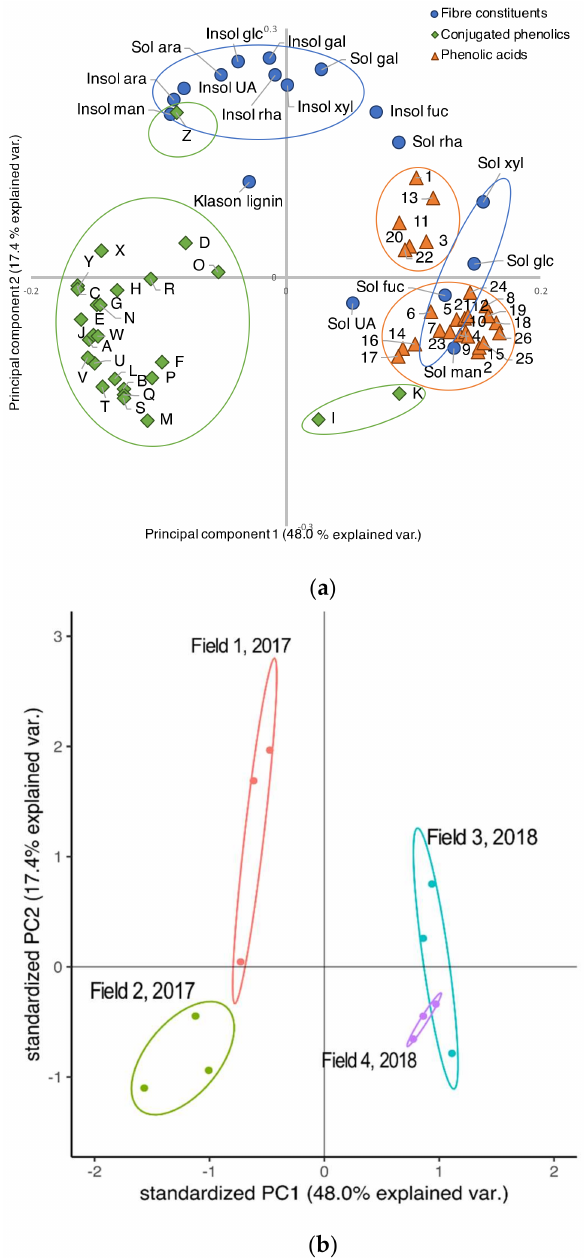
Figure 1. Loading plot (a) and score plot (b) for the principal component analysis for dietary fiber constituents (Klason lignin and sugar residues), conjugated phenolics and phenolic acids (after hydrolysis) from broccoli leaves. Each data point is the mean from three replications, n = 3. Insol: insoluble. Sol: soluble. UA: uronic acid. Rha: rhamnose. Fuc: fucose. Ara: arabinose. Xyl: Xylose. Man: mannose. Gal: galactose. Glc: glucose. For a tentative identification of the peaks in conjugated phenolics see Table 5. For the phenolic acids, Peaks 2, 4, 5, 8, 9, 10, 16 and 19 have a tentative identification (Table S1), and HPLC and MS spectra can be found in Figure S7 and Figure